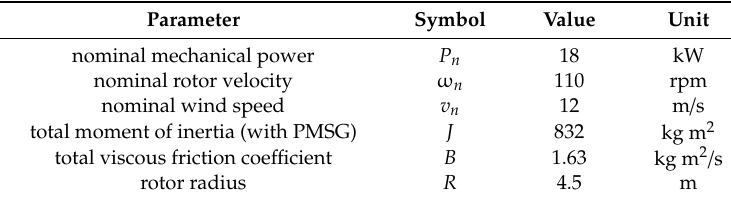
Table 1. Wind turbine parameters.